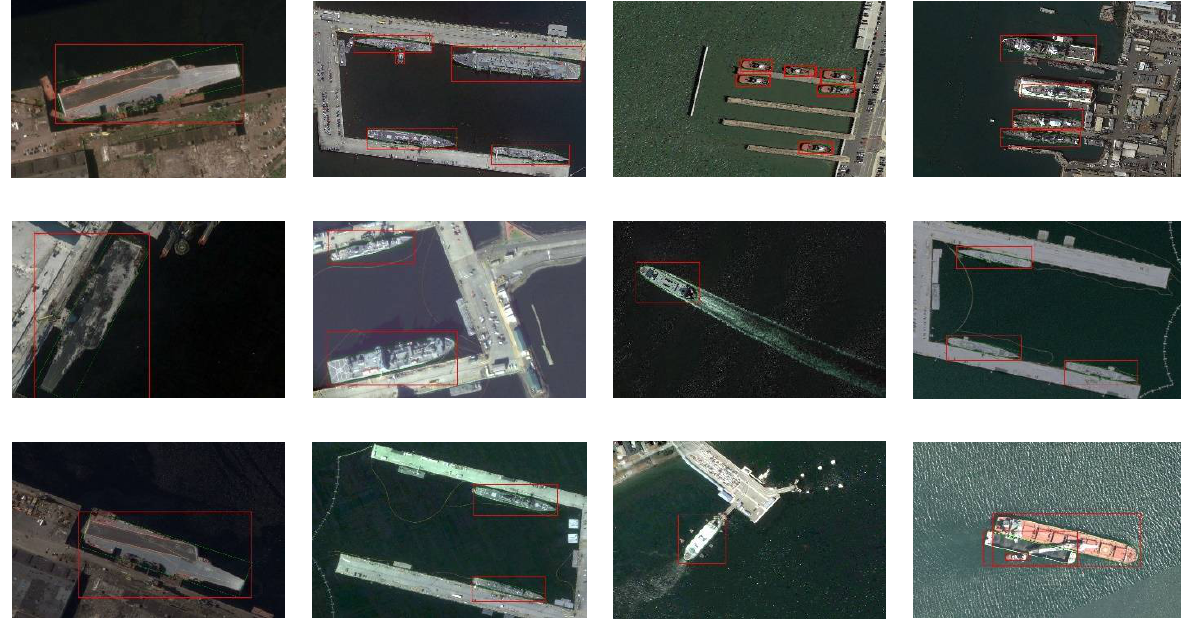
Figure 8. HRSC2016 samples. Training samples, validation samples, and test samples are displayed in the first, second and third rows, respectively.